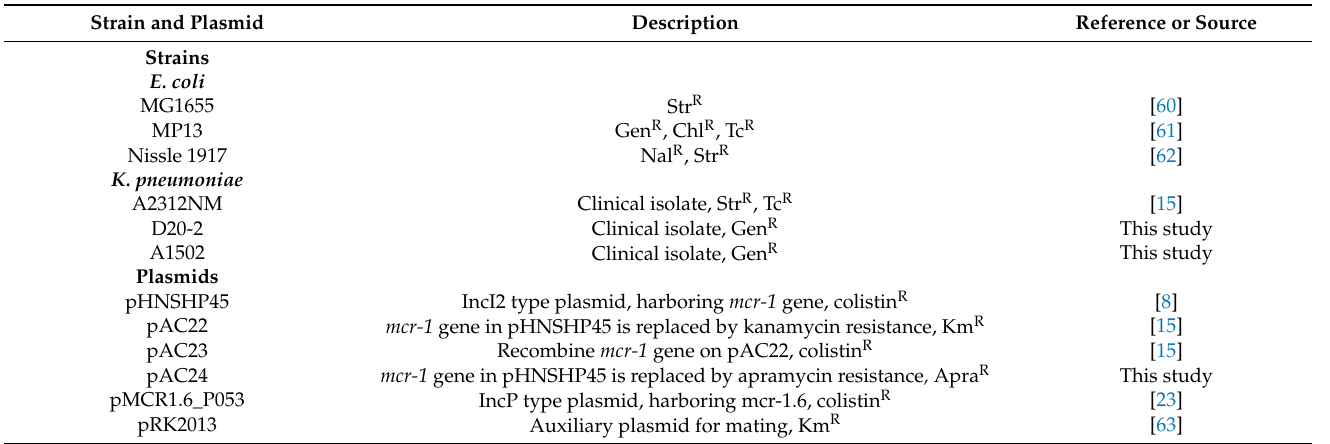
Table 1. Strains and plasmids used in this